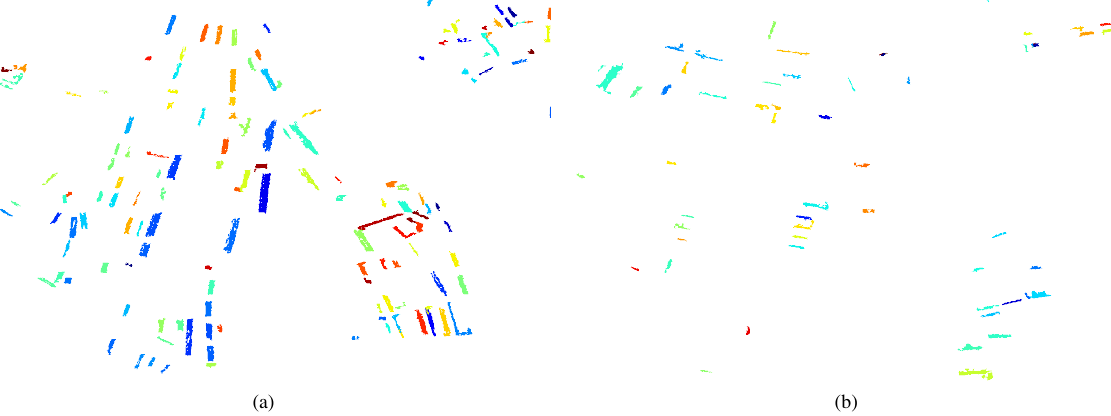
Figure 11: Final segmentation results for both (a) high and (b) low reflectivity regions. Each building part is assigned a different color.